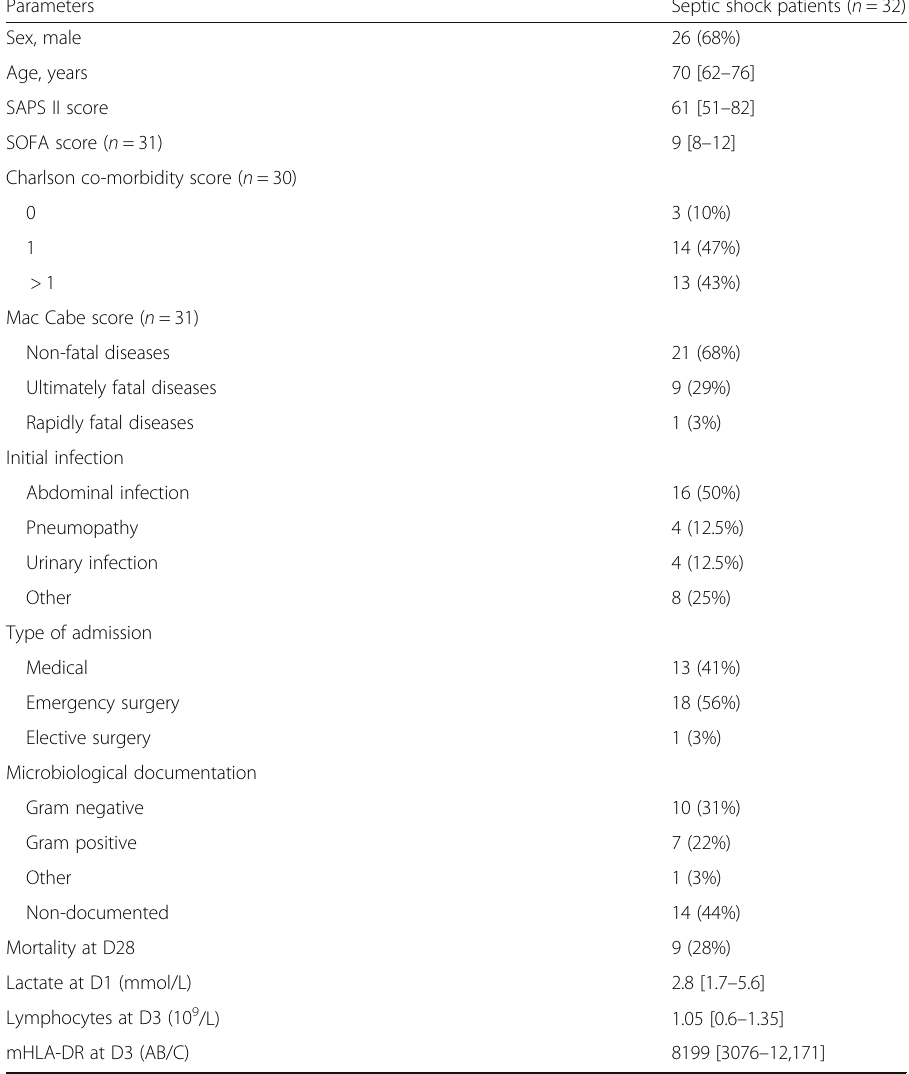
Table 1 Clinical characteristics of septic shock patients Parameters Septic shock patients ( n =